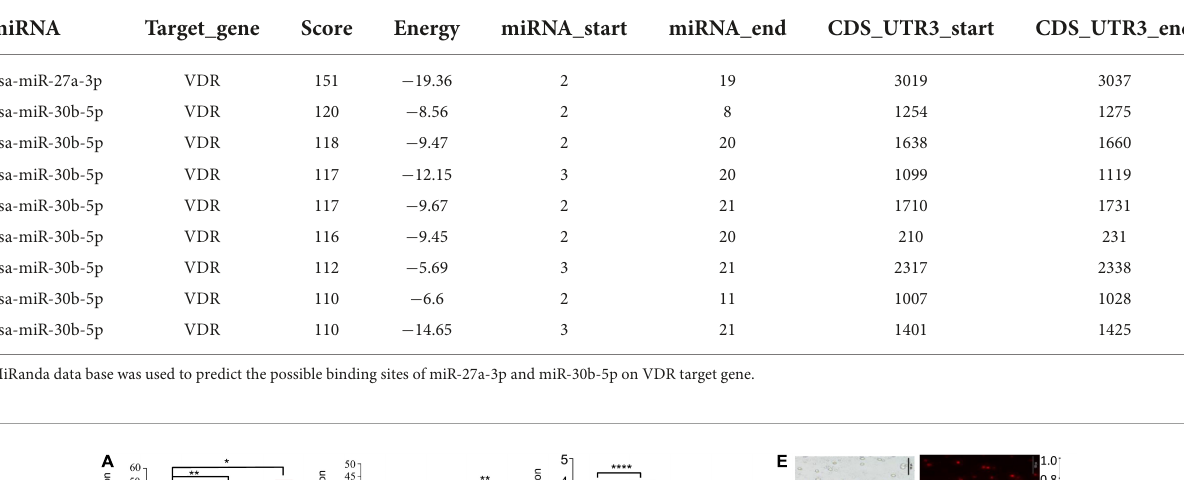
TABLE 4 MicroRNA (MiRNA) target predictions based on miRanda.